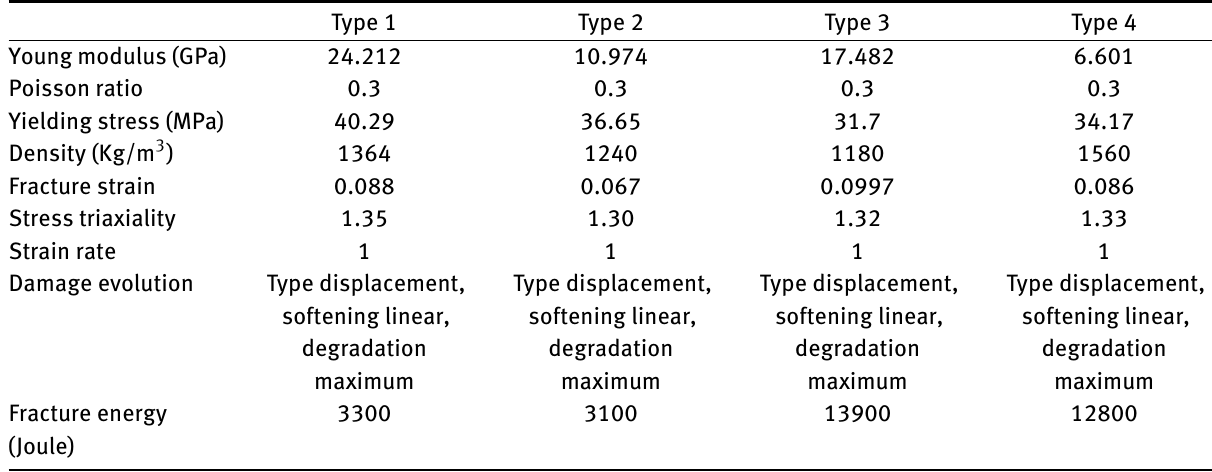
Table 2: Properties of the materials used in the FE